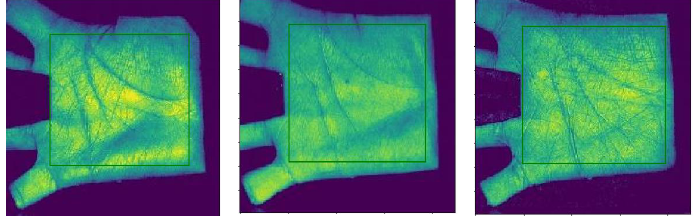
Figure 7. Examples of extracted palmprint ROIs in the testing